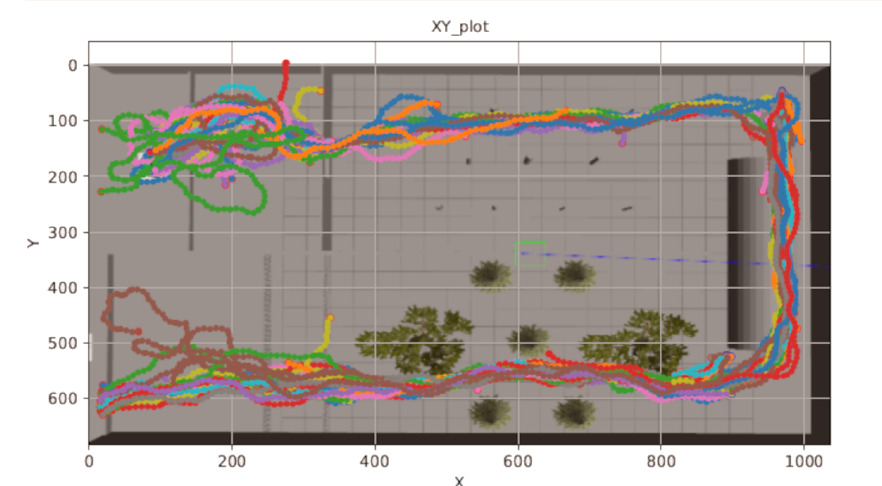
Figure 14. This diagram illustrates the navigation of UAV using trained SCAN in the challenging environment. The top left image shows the top-view navigation trajectory of UAV projected on the top view of the environment map.